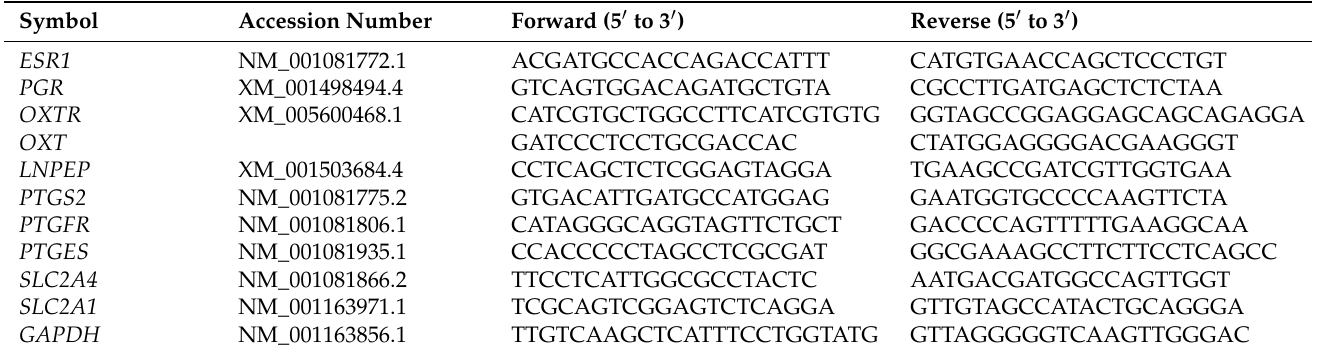
Table 1. Genes, accession number, forward (5 (cid:48) ->3 (cid:48)(cid:48) ) and Reverse (3->5)